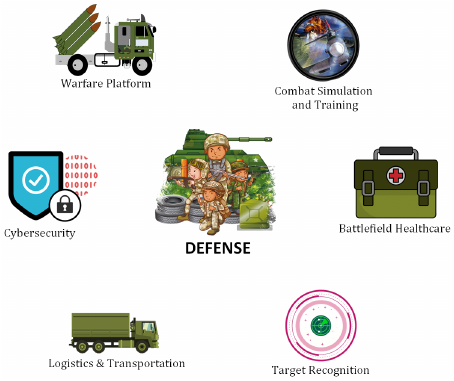
Figure 19. Applications of DL in defense. Table 8. State-of-the-art contributions in DL-based defense